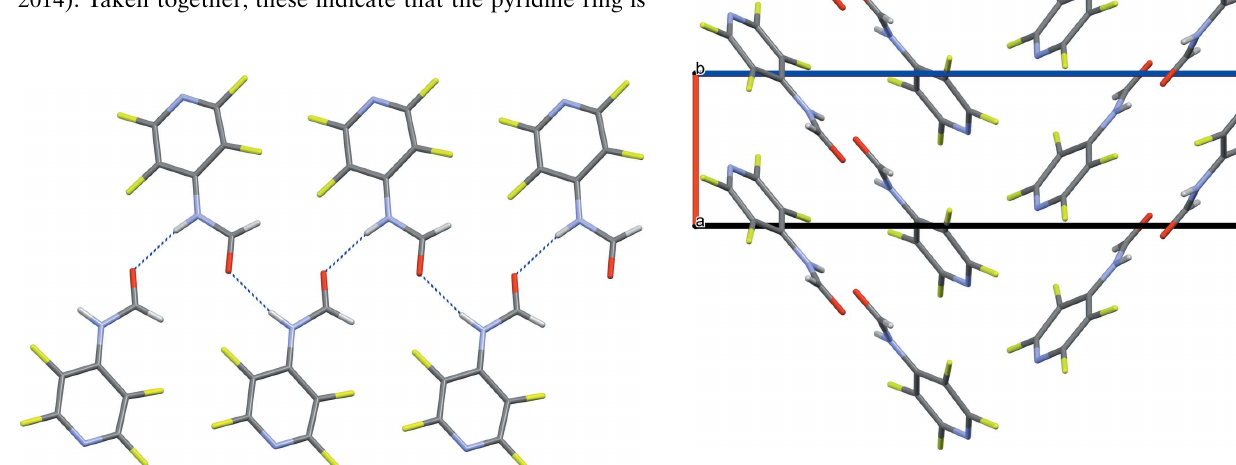
Figure 2 Intermolecular hydrogen bonding forming a chain propagating along the b -axis direction where hydrogen bonds are represented with dashed lines.